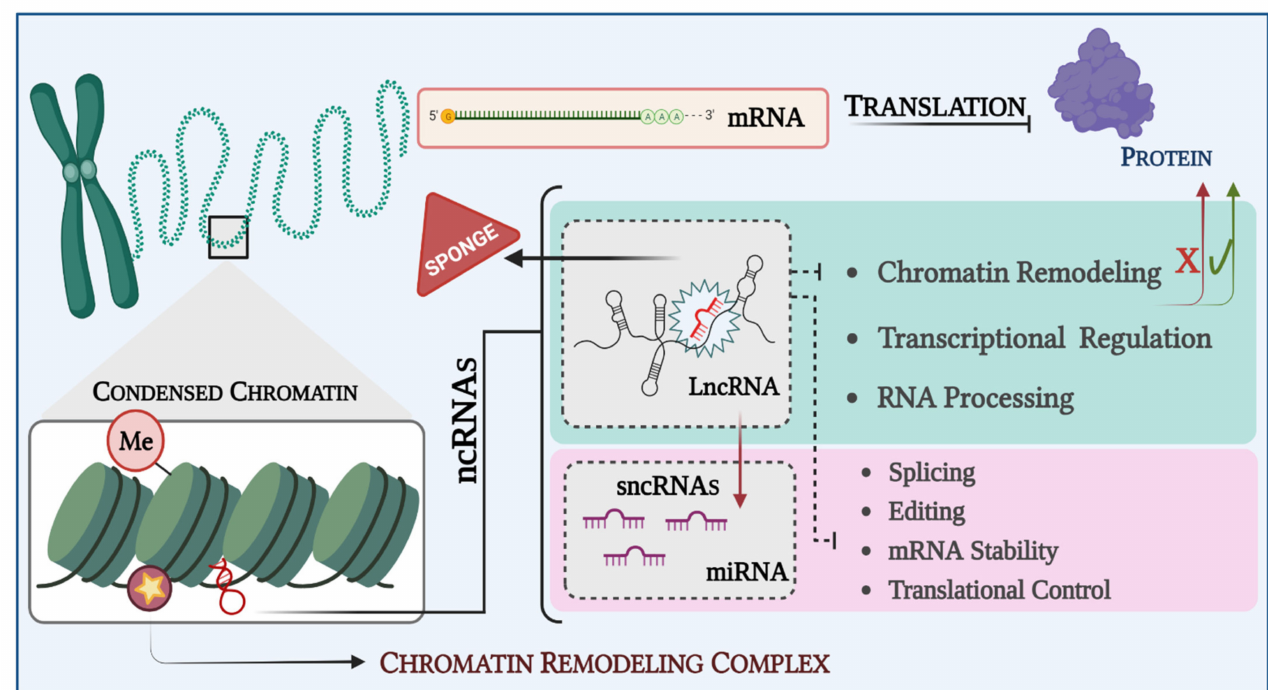
Figure 5. Graphical representation of the ncRNAs dysregulation in LMS and ESS. ncRNAs have been identified as oncogenic drivers or tumor suppressors in cancer. LncRNAs often affect the expression of their target genes by interacting with miRNAs, which are the main post-transcriptional regulation factors. Some lncRNAs act like sponges, thereby preventing miRNAs from binding to their target mRNAs. As lncRNAs work as decoys for miRNAs, oncogene mRNA translation is allowed, starting the LMS and ESS carcinogenesis. Created with